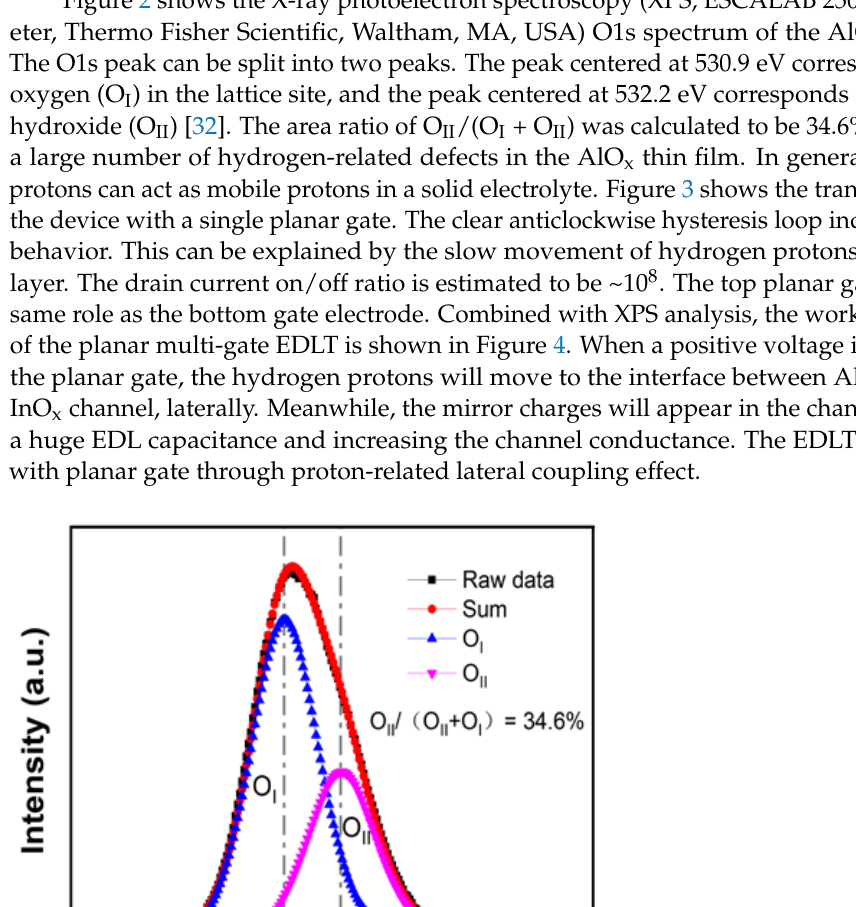
Figure 1. ( a – e ). Fabrication schematic of multi-gate artificial synaptic transistor with InO x channel and AlO x electric-double-layer (EDL) dielectric. S, D, and G represent source, drain and gate.